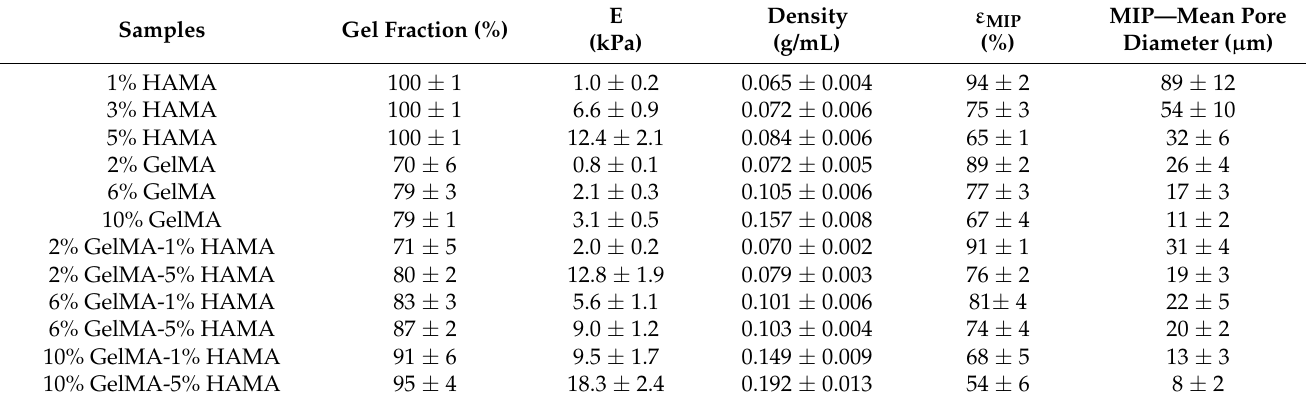
Table 1. Summary of compositions and physico-chemical properties of